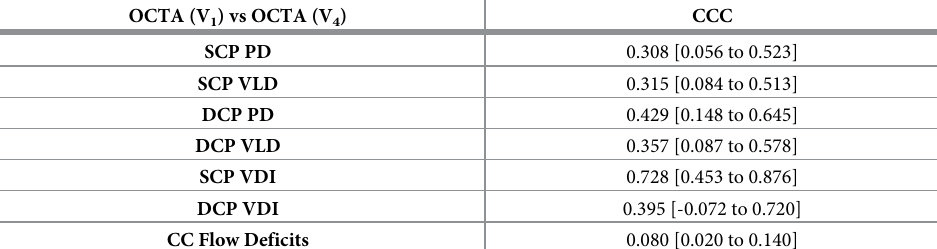
Table 3. Inter-methods repeatability of measurements: CCC = concordance correlation